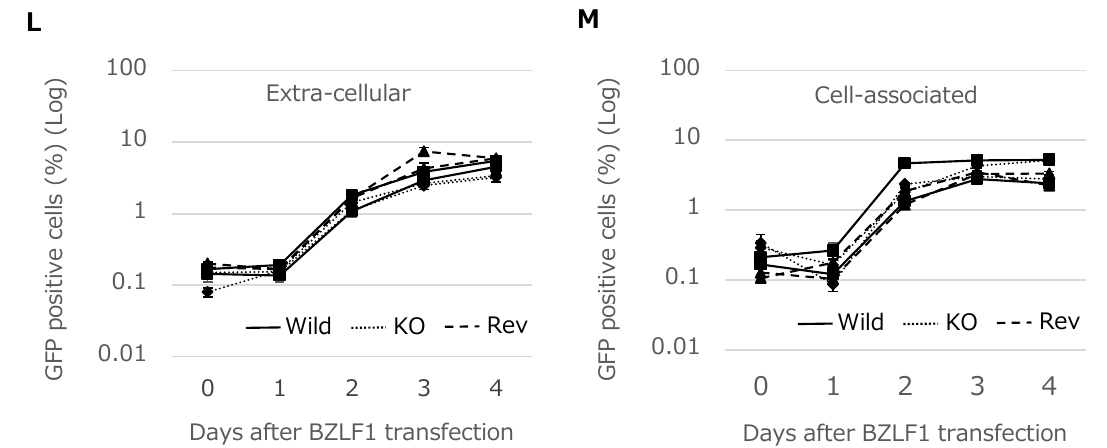
Figure 2. Protein expression, DNA replication, and progeny production of BSRF1 KO EBV in HEK293 cells. ( A ) Viral protein expression in HEK293. HEK293 EBV-BAC cells were transfected with